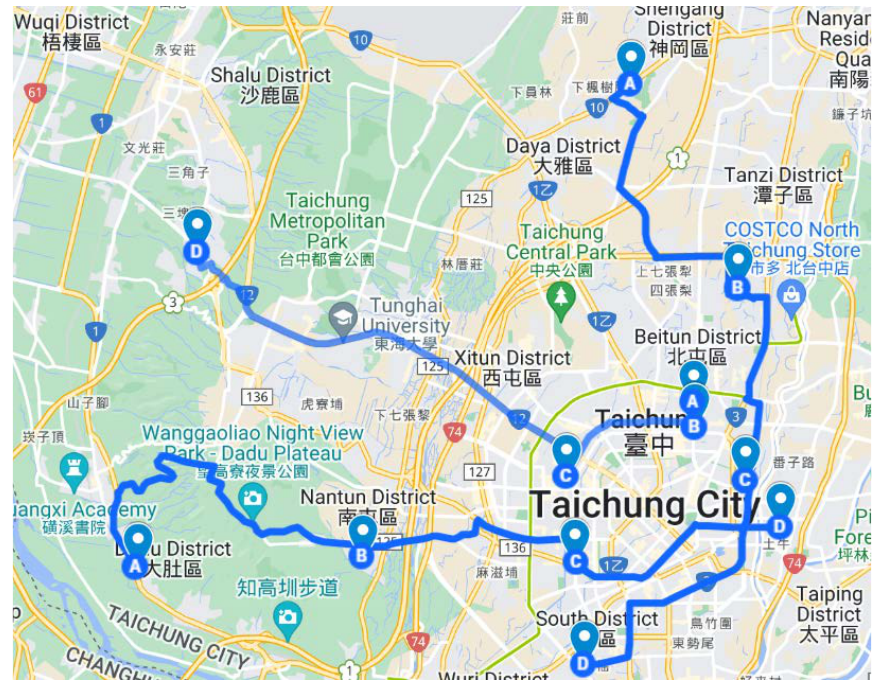
Figure 3. Results shown on a map.